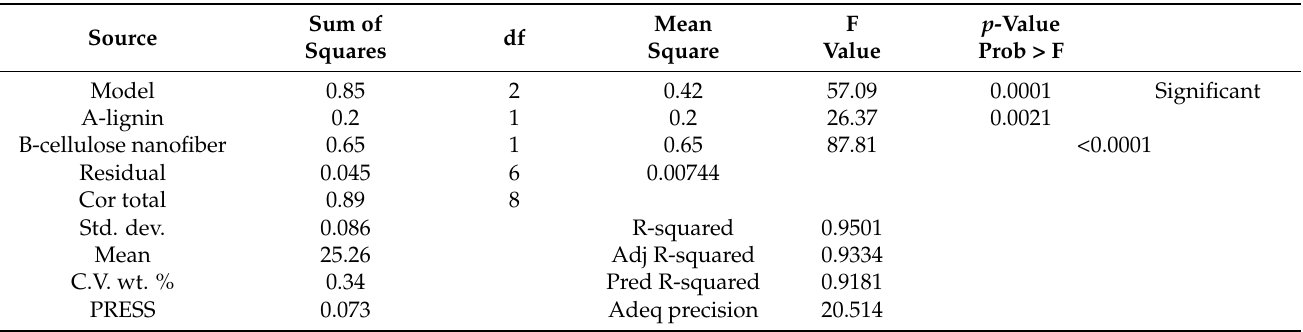
Table 4. ANOVA for response surface quadratic model for YM lignin–cellulose nanofiber-filled thermoplastic starch composite film.